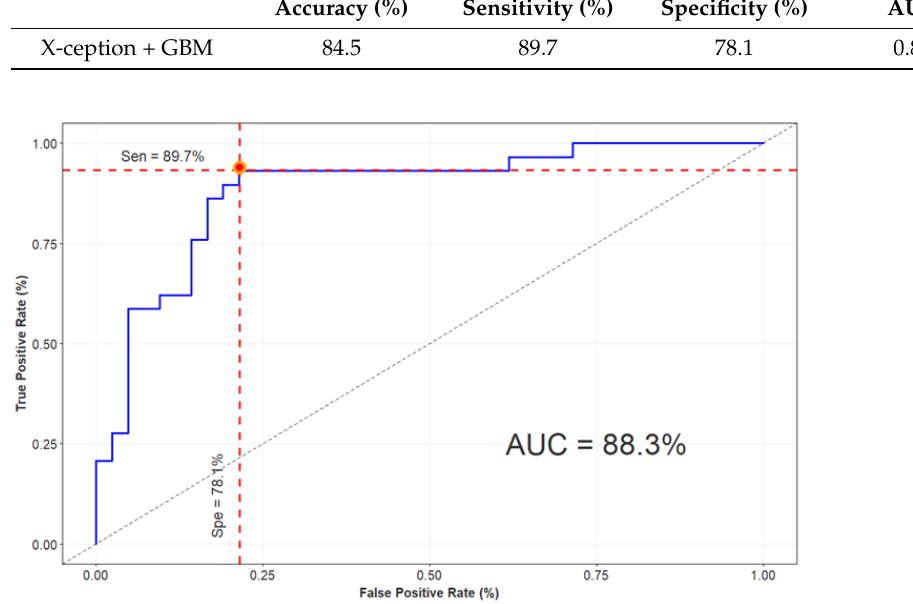
Figure 5. ROC curve of combination model performance.